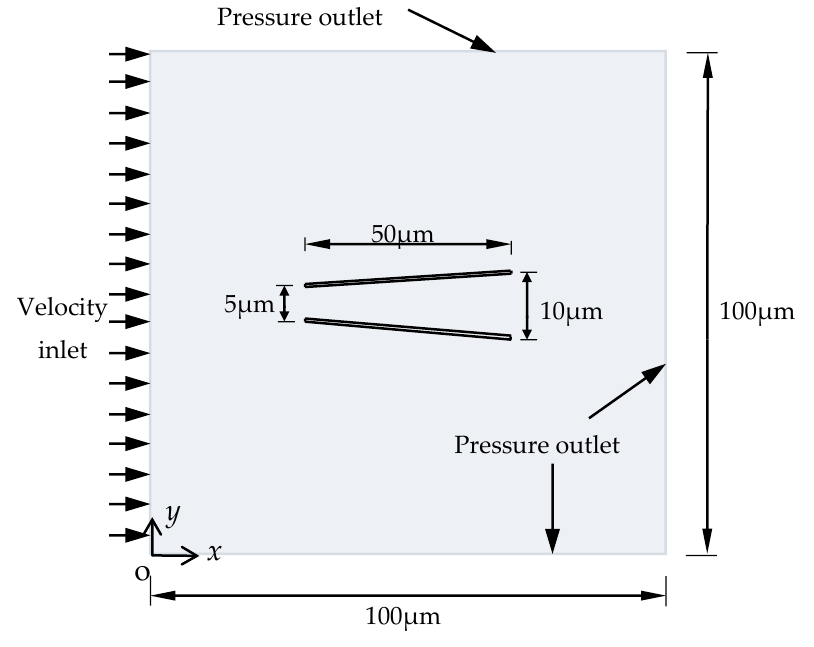
Figure 5. The boundary conditions and the shape of the micromotor.